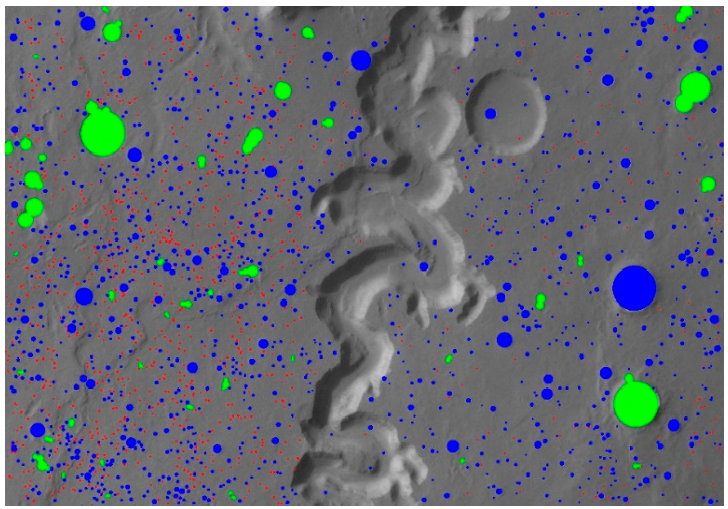
Figure 11. Red craters are small craters, and green craters are overlapping craters. Both the red and green craters were removed, while blue craters were the navigation craters that remained in the end.